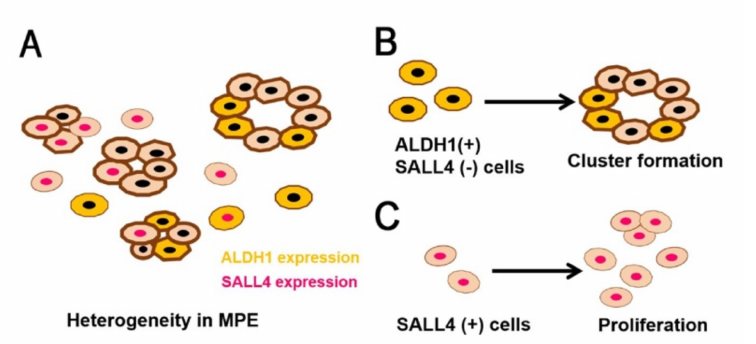
Figure 6. Schematic model of lung adenocarcinoma with malignant pleural effusion (MPE). ( A ) Tumor cells in MPE are heterogeneous. MPE samples exhibited clusters and isolated cells, and some tumor cells expressed aldehyde dehydrogenase 1 (ALDH1) or Sal-like 4 (SALL4). ( B ) The subpopulation consisting of ALDH1-positive/SALL4-negative cells has capacity to form clusters, which is a stem-like property. ( C ) SALL4 expression is related to cellular